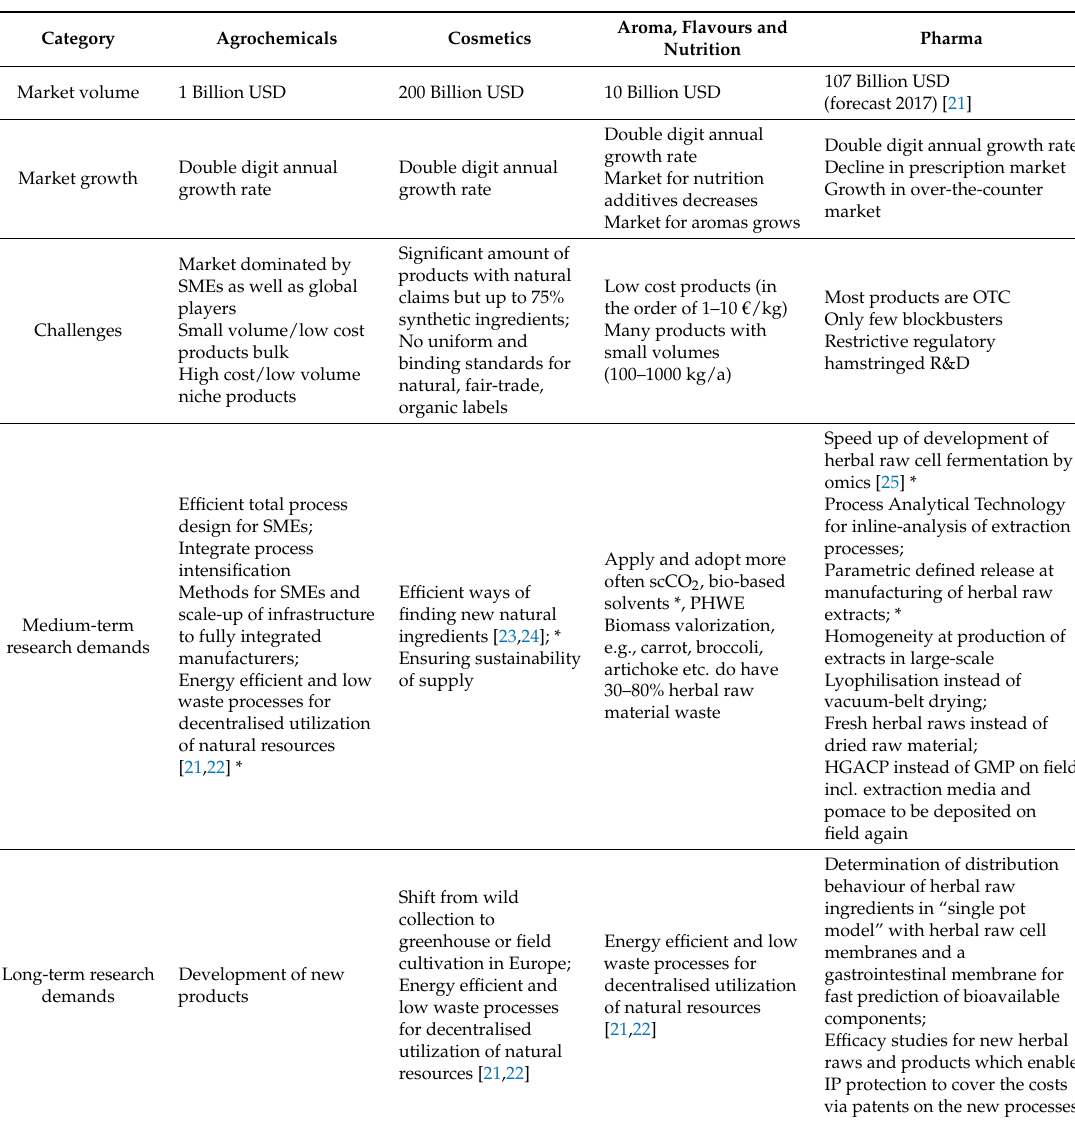
Table 1. Overview of trends, perspectives, market situation, and research demand based on [1] when not stated